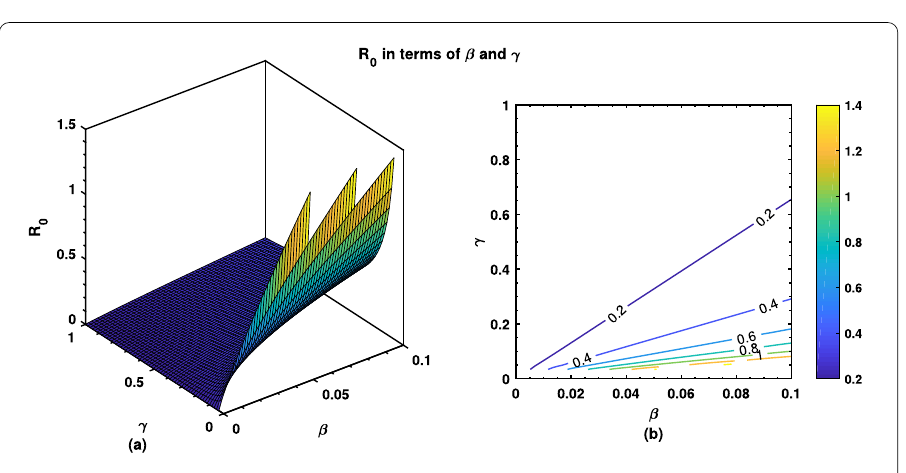
Figure 11 Behavior of the basic reproductive